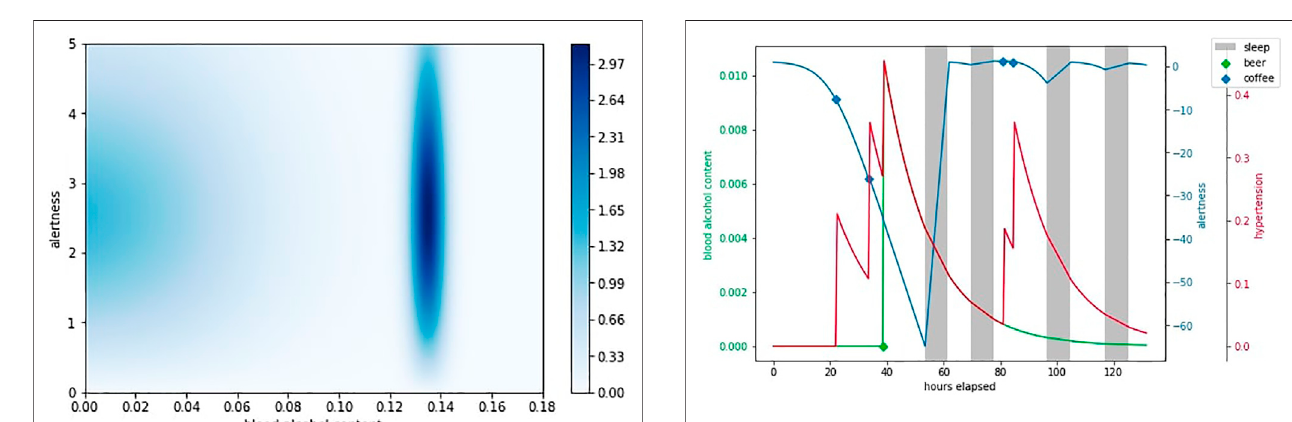
FIGURE 7 | An example episode in